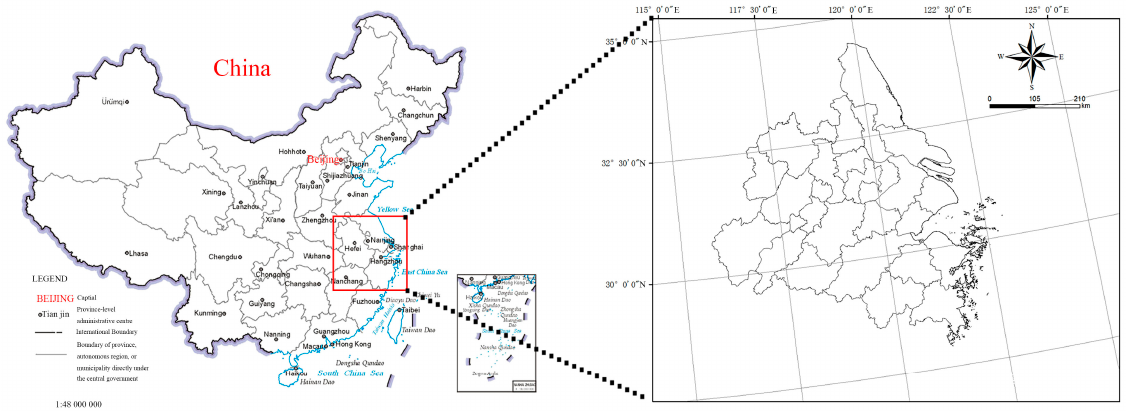
Figure 1. Location map of the Yangtze River Delta (source: http://bzdt.ch.mnr.gov.cn/ accessed on 18 November 2022).